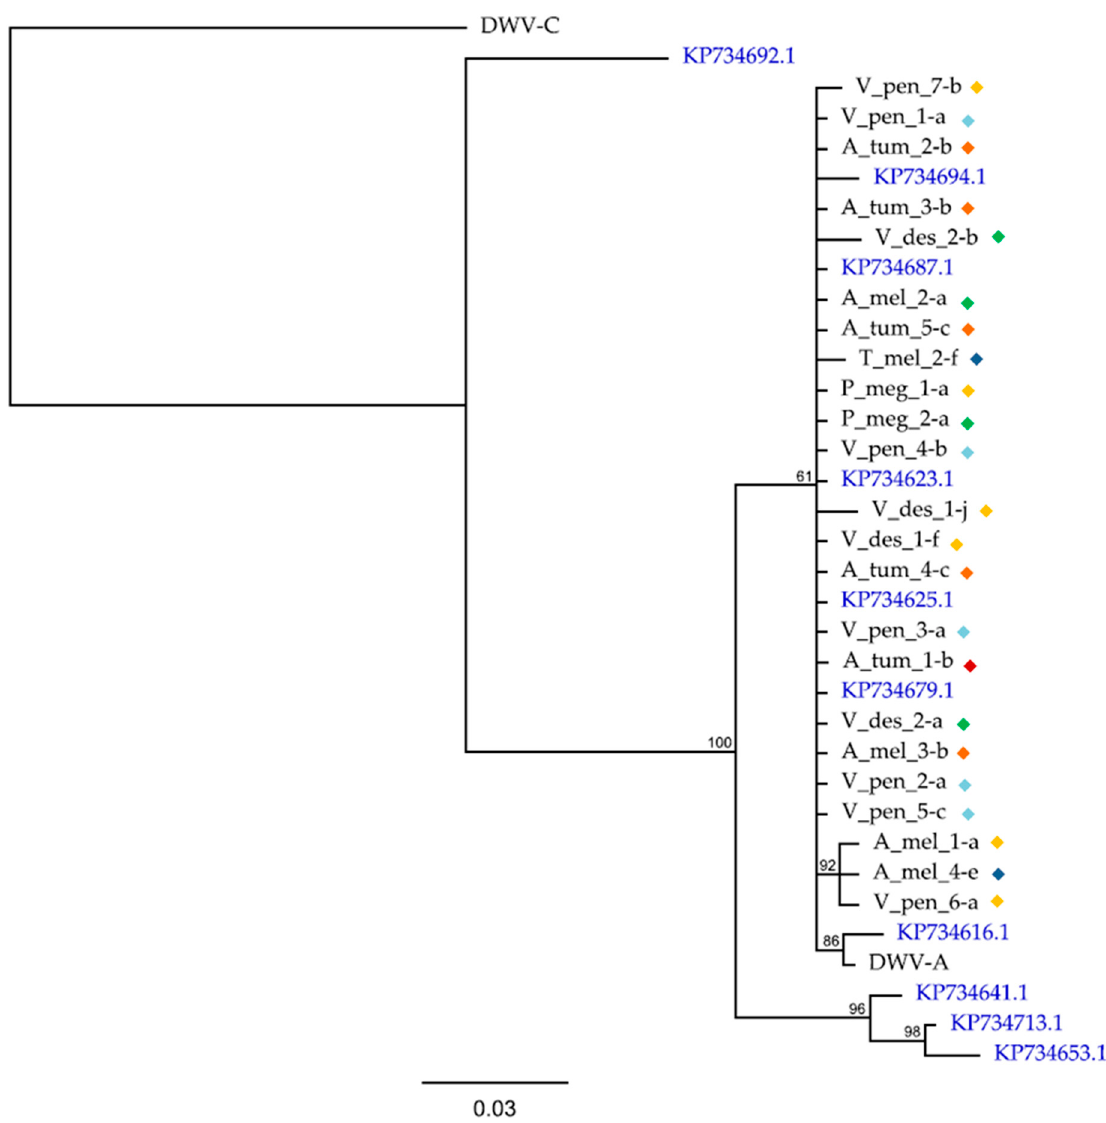
Figure 4. A Bayesian phylogeny of a 410 bp region of the DWV-A RdRp gene using trimmed contigs assembled for each sample individually using VICUNA, along with 10 additional sequences, as featured in the global DWV-A phylogeny of [4] (shown in blue text). Colored diamonds represent the site from which the sample was collected as follows: O1 = green, O2 = red, B1 = orange, B2 = dark blue, B3 = yellow, and B4 = light blue. Sample name suffixes represent the contig name. DWV-C is used as the outgroup, and the bar represents the number of nucleotide substitutions per site. Consensus support values (%) are shown.